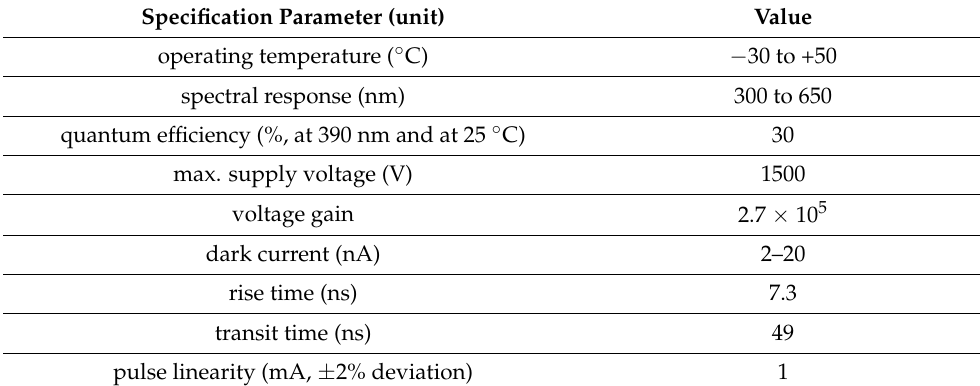
Table 3. Specifications of the used photomultiplier tube (PMT) [R10131-01, Hamamatsu